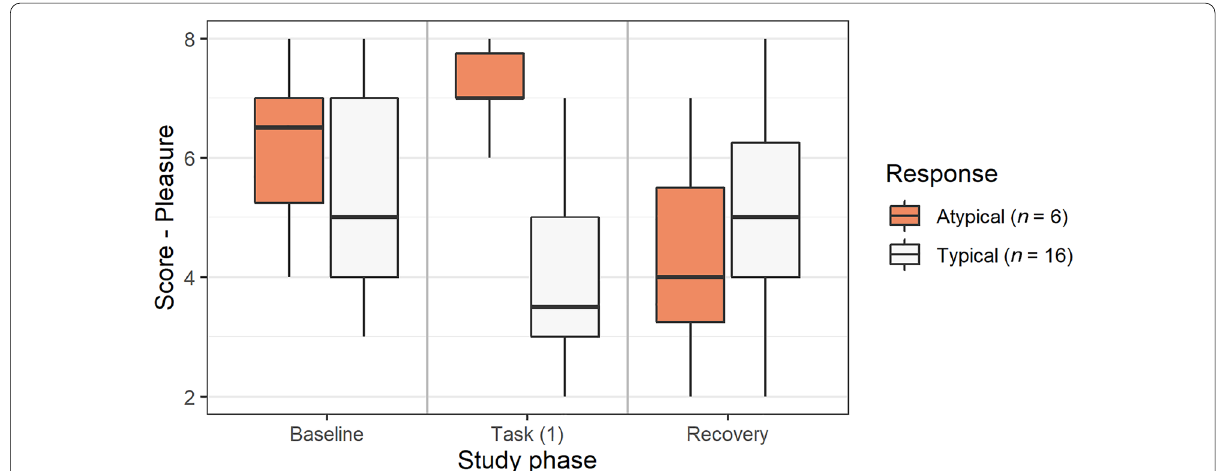
Fig. 5 Pleasure scores across study phases for participants with atypical and typical